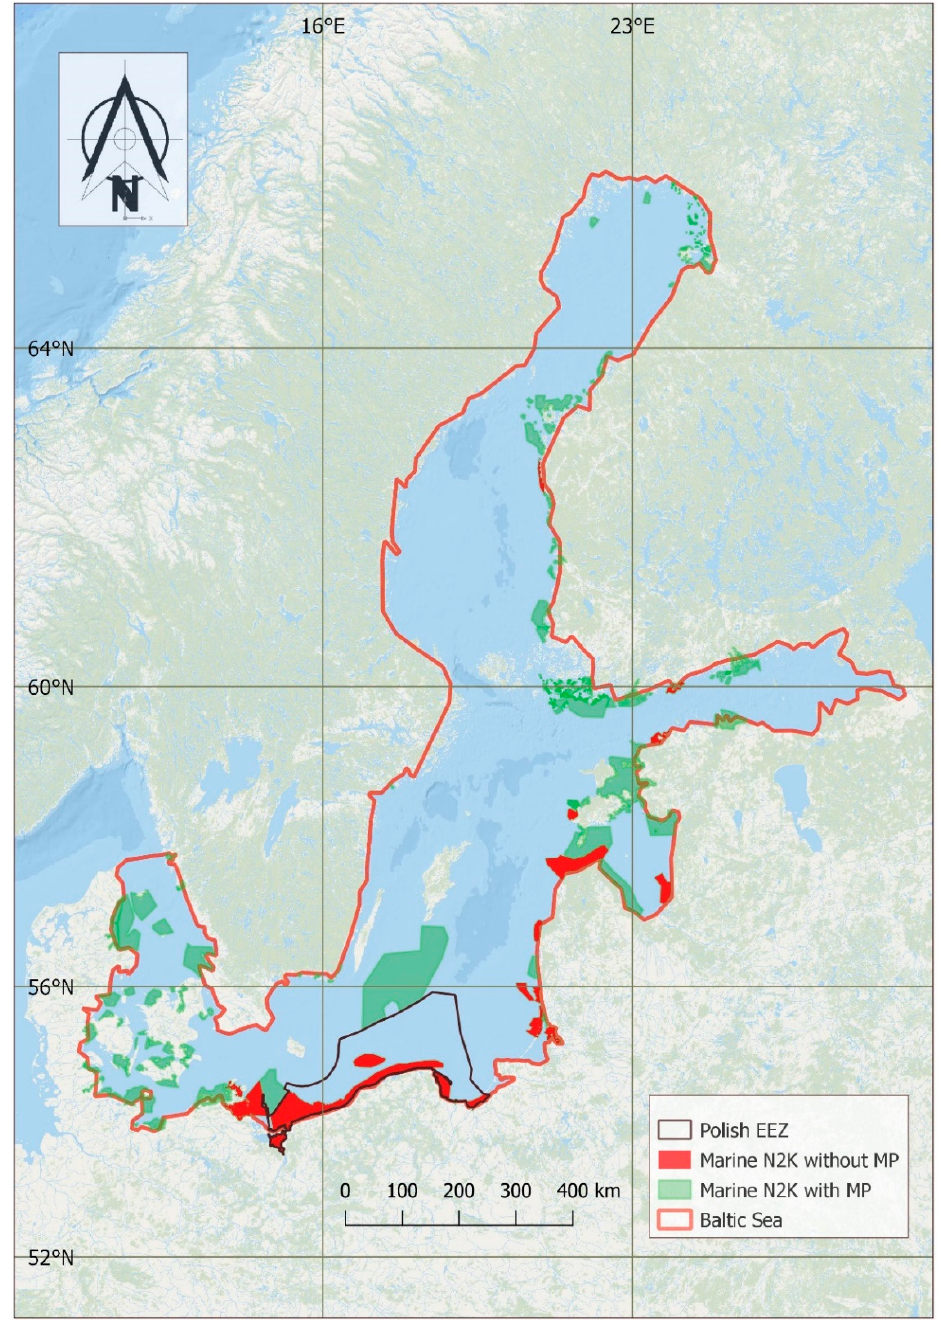
Figure 1. Study area—Baltic Sea, 117 Natura 2000 (N2K) areas established to protect waterbirds during their migration and wintering, with indication of which of them have a Management Plan (MP). Map created in QGIS ver. 3.4.8-Madeira (https://qgis.org/ accessed on 18 May 2019) under the GNU General Public License by Dominik Marchowski.